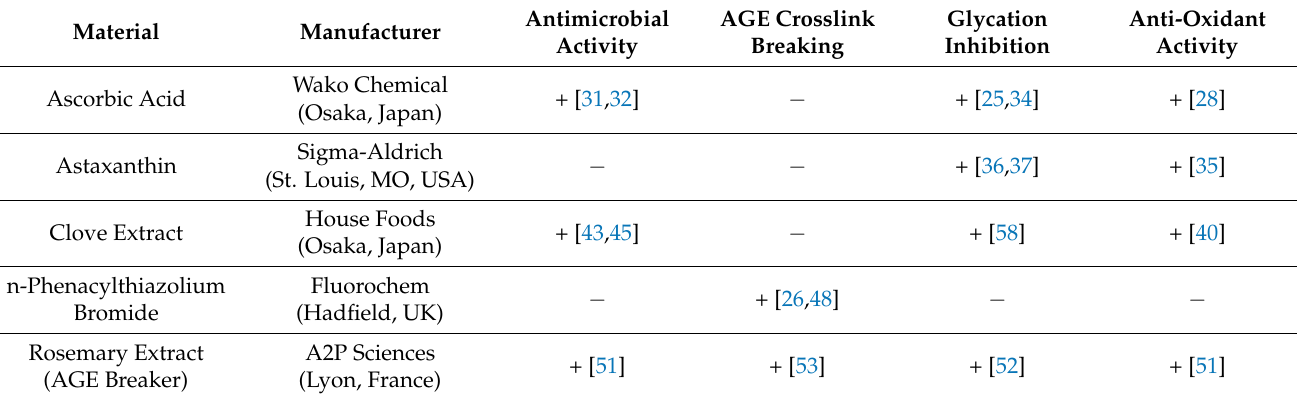
Table 2. Reported Properties of Test